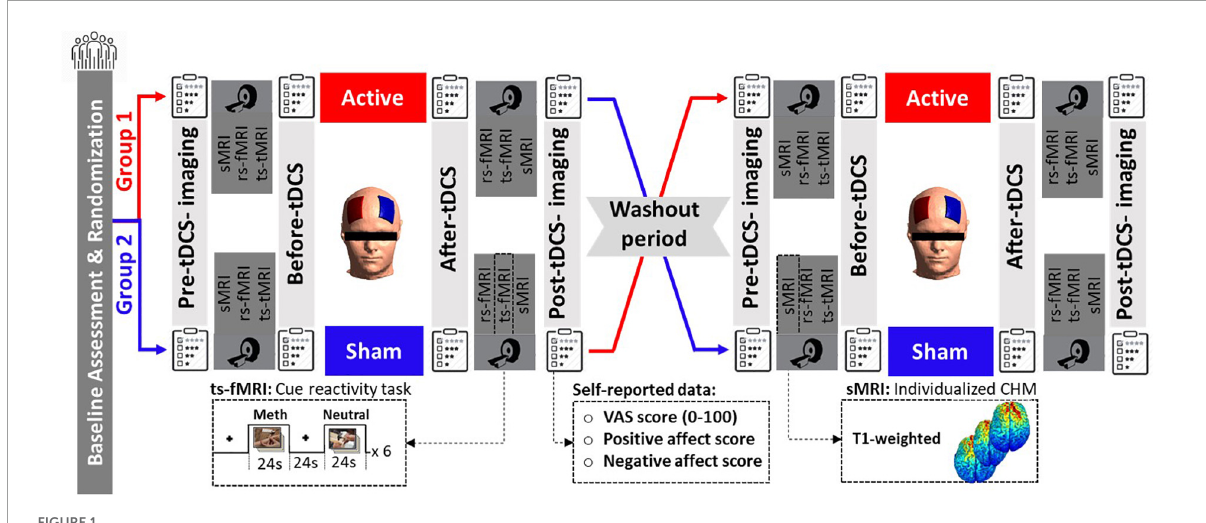
FIGURE1 Data acquisition procedure. Fifteen participants with methamphetamine use disorder underwent real and sham tDCS randomly on separate days. tDCS was applied for 20 min at 2 mA through 5 × 7 cm 2 sponge electrodes with the anode over F4 and the cathode over F3. In this clinical cross-over, double-blinded, sham control trial, neuroimaging data, including structural MRI (sMRI), resting-state (rs-fMRI), and task-based (ts-fMRI) fMRI data, were collected in a pre-stimulation/post-stimulation design. fMRI task was a standard cue-reactivity task with a pictorial block design that consisted of meth vs. neutral stimuli, and sMRI data were included in T1-weighted data used for creating individualized computational head models. Self-report data, including VAS and PANAS, were also collected before and after stimulation.